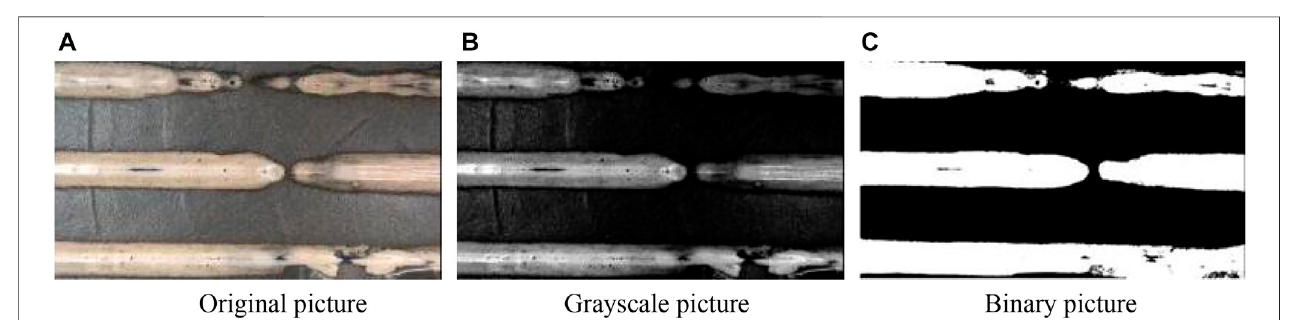
FIGURE 11 | Display of picture-processing results. (A) Original picture, (B) grayscale picture, and (C) binary picture.